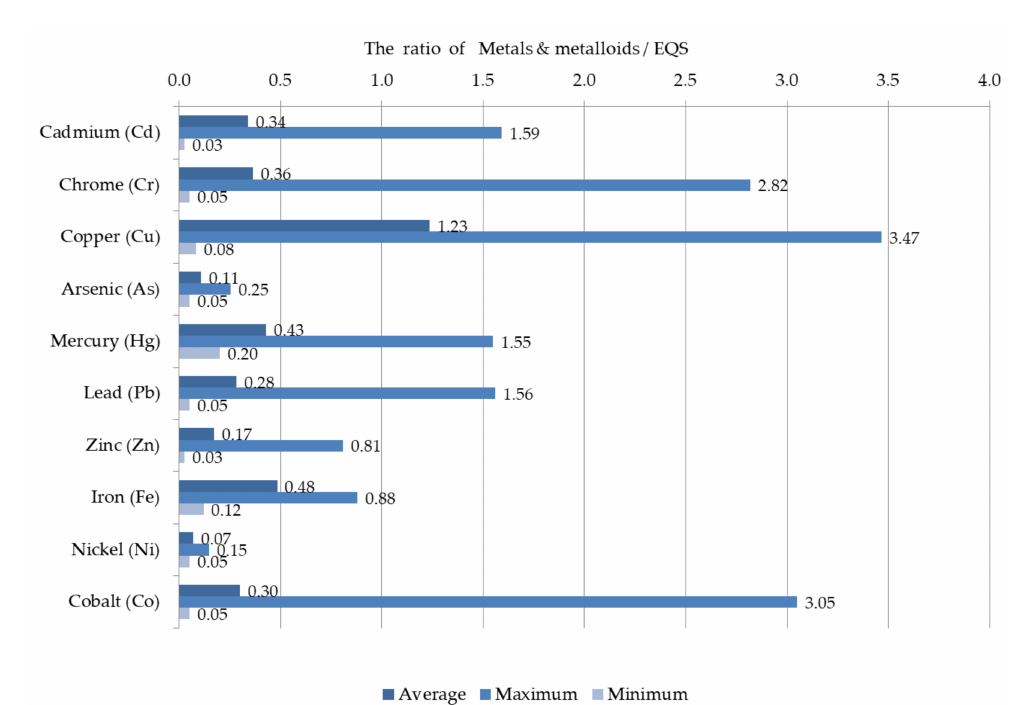
Figure 4. The ratio of average and extreme concentrations of heavy metals and metalloids to their environmental quality standards (EQS) in the waters of the Lower